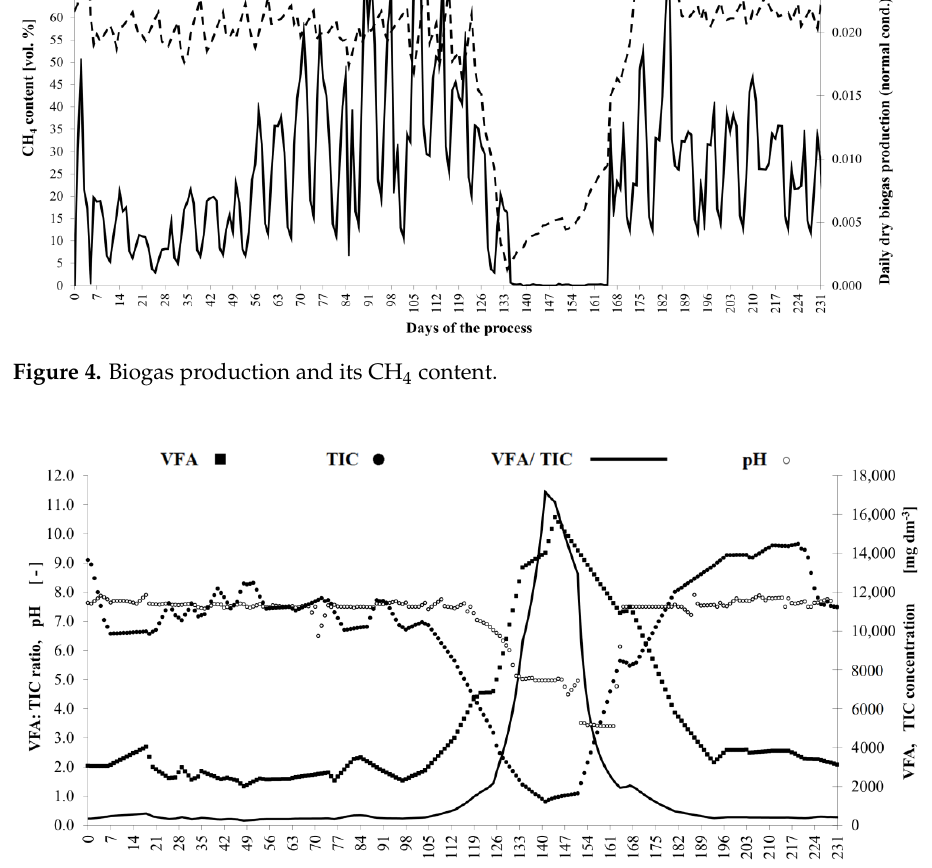
Figure 5. VFA and TIC versus pH.